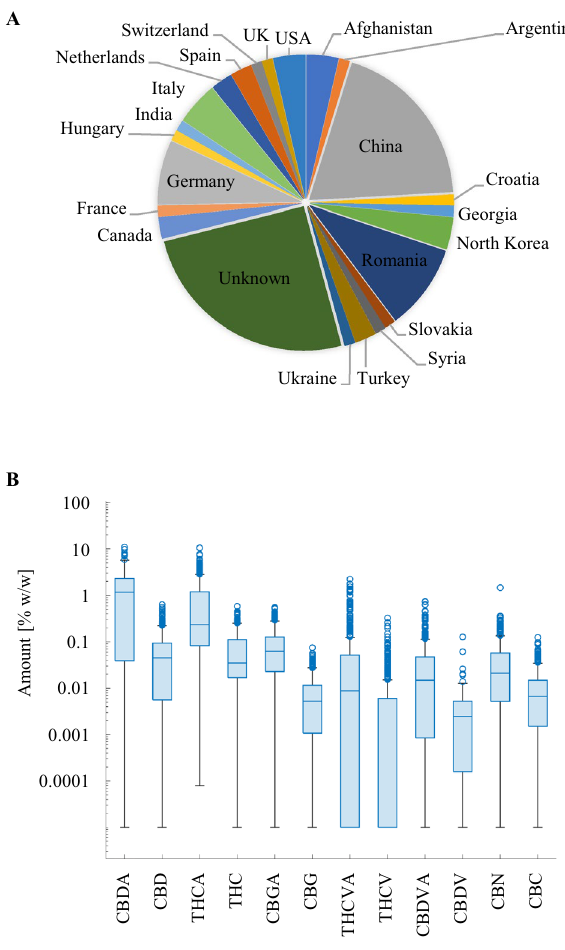
Figure 1. Geographic distribution and cannabinoid abundance of 84 accessions. ( A ) geographic distribution of the 84 accessions based on passport data. ( B ) Cannabinoid abundance of 12 cannabinoids across 249 samples, obtained from the HPLC reference analysis. Open circles represent outlier cannabinoid measurements above one standard deviation. The median value is represented by the line in the box, while the T bars are the lower and upper quartiles. A log-10 scale was applied on the y-axis. Cannabidiolic acid (CBDA), Cannabidiol (CBD), Δ9-Tetrahydrocannabinol acid (THCA), Δ9-Tetrahydrocannabinol (THC), Cannabigerolic Acid (CBGA), CBG (Cannabigerol), Tetrahydrocannabivarinic acid (THCVA), Tetrahydrocannabivarin (THCV), Cannabidivarinic acid (CBDVA), Cannabidivarin (CBDV), Cannabinol (CBN), Cannabichromene